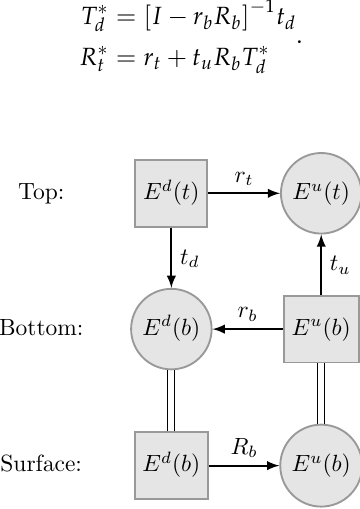
Figure 1. Flux interaction diagram for the combination of a vegetation layer on top of a reflecting surface (e.g., soil). A rectangle stands for incident radiation and a circle for reflected or transmitted radiation. The rectangles and circles are connected by arrows that indicate the direction of flow, and a symbol next to the arrow indicates the corresponding reflectance or transmittance. The notations t and b in the brackets indicate the top of and bottom of a vegetation layer, respectively. r and t are the reflectance and transmittance matrices where the subscripts attached to the matrices denote downward ( d ), upward ( u ), top ( t ), and bottom ( b ) (i.e., r t and r b are the reflectance at top and bottom of the vegetation layer, respectively. t d and t u are the downward and upward transmittance,